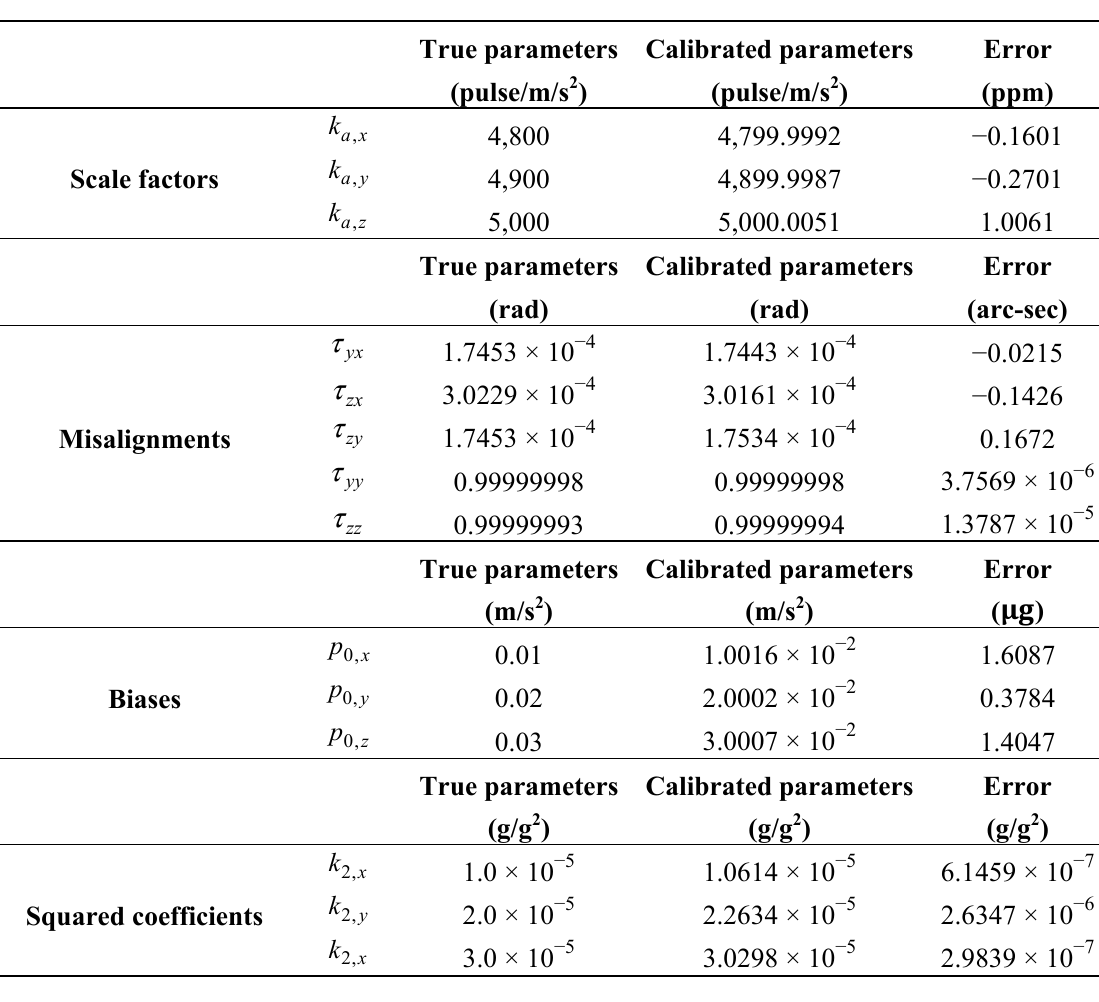
Table 3. A set of simulation results for triaxial